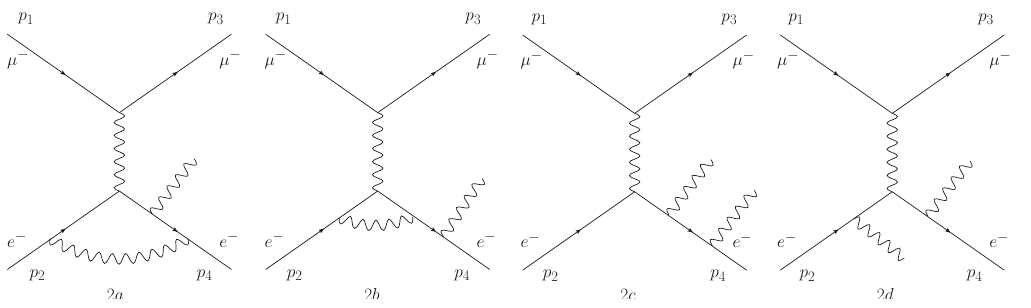
Figure 1 . Virtual QED corrections to the electron line in (cid:22)e (diagram 1a); sample topologies for the two-loop corrections (diagrams 1b-1d). The blob in diagram 1d denotes an electron loop insertion. On-shell scheme counterterms are understood.